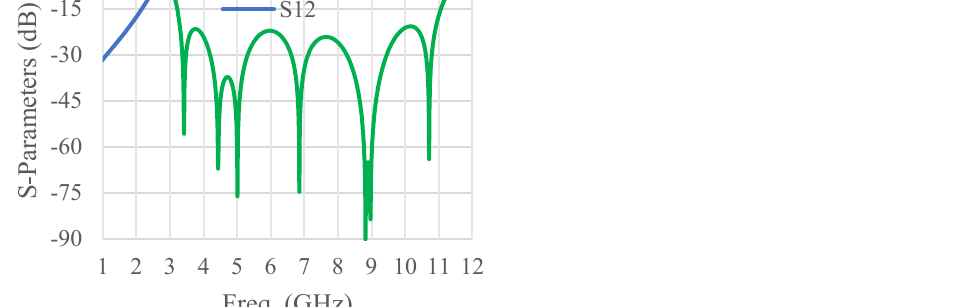
Figure 8. Simulated S − parameters results of the lumped element filter represented in Figure 7.